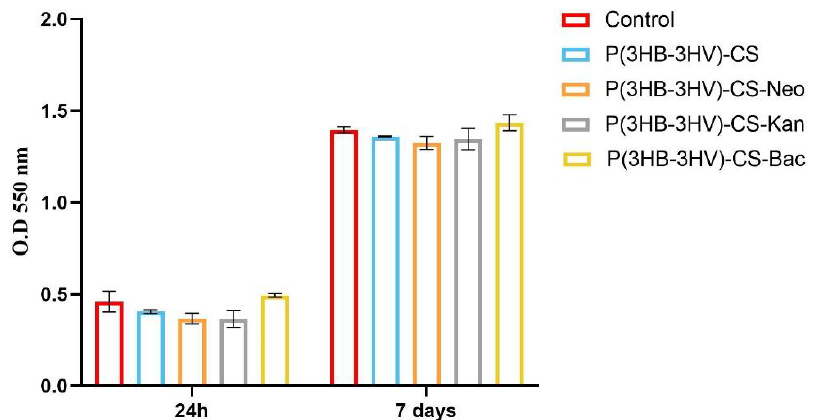
Figure 4. Graphic representation of human dermal fibroblasts viability after 24 h and 7 days of exposure to simple and Bac-/Neo-/Kan-loaded P(3HB-3HV)-CS spheres as revealed by the MTT assay. The represented data are the mean values of three independent experiments ± S.D.